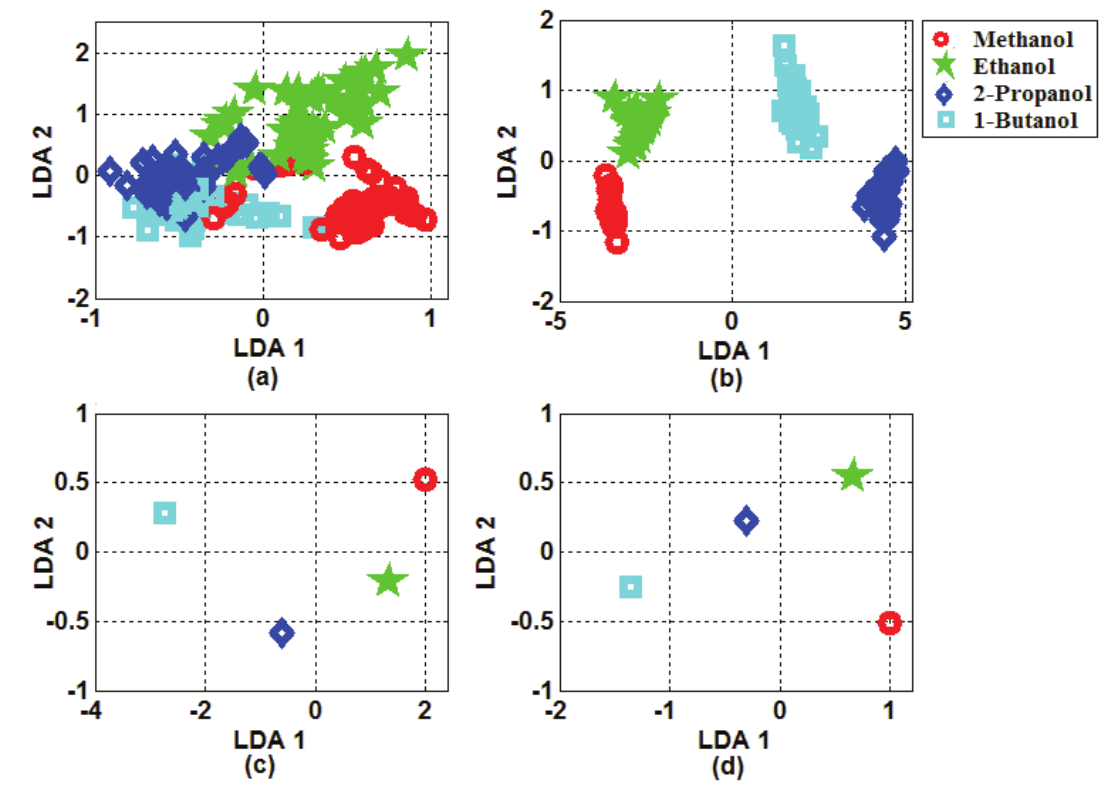
Figure 6. (a) LDA Projection results of the first 25 samples selected portions of transient response. (b) The same for the first 50 samples. (c) The same for the first 75 samples. (d) The same for the first 100